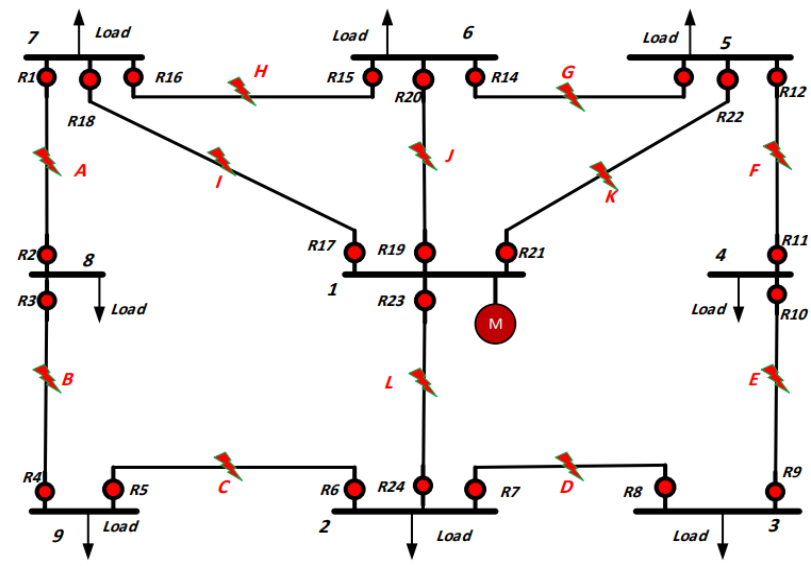
Figure 13. IEEE 9-Bus MG system, meshed network.